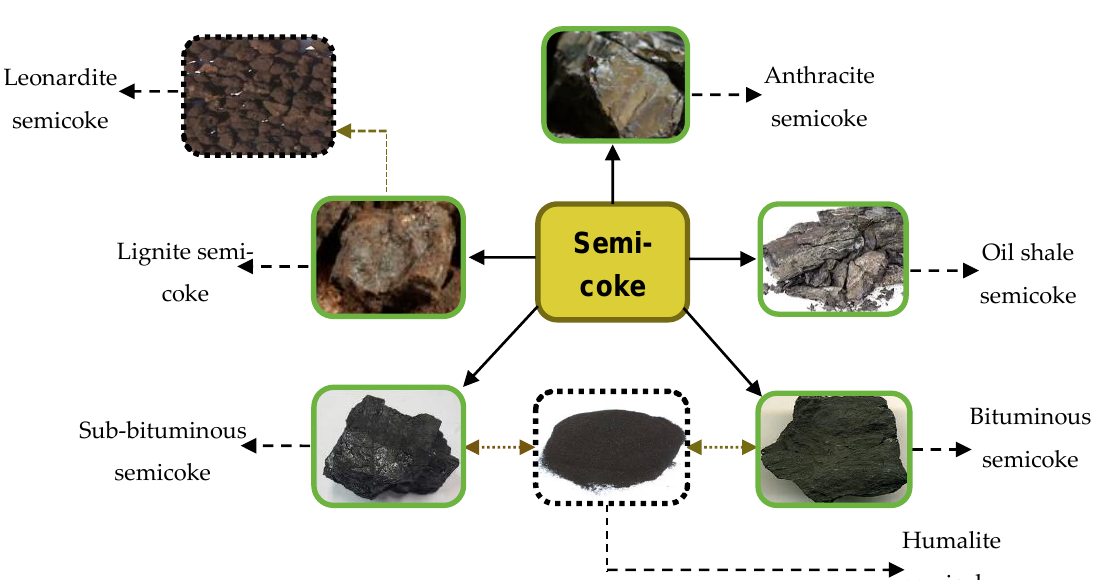
Figure 2. Classification of semicoke types after processing.